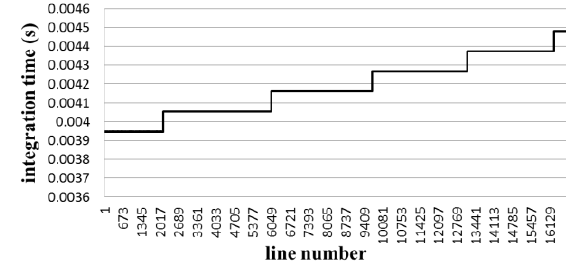
Figure 6. Integration time of h4235_0001_s12